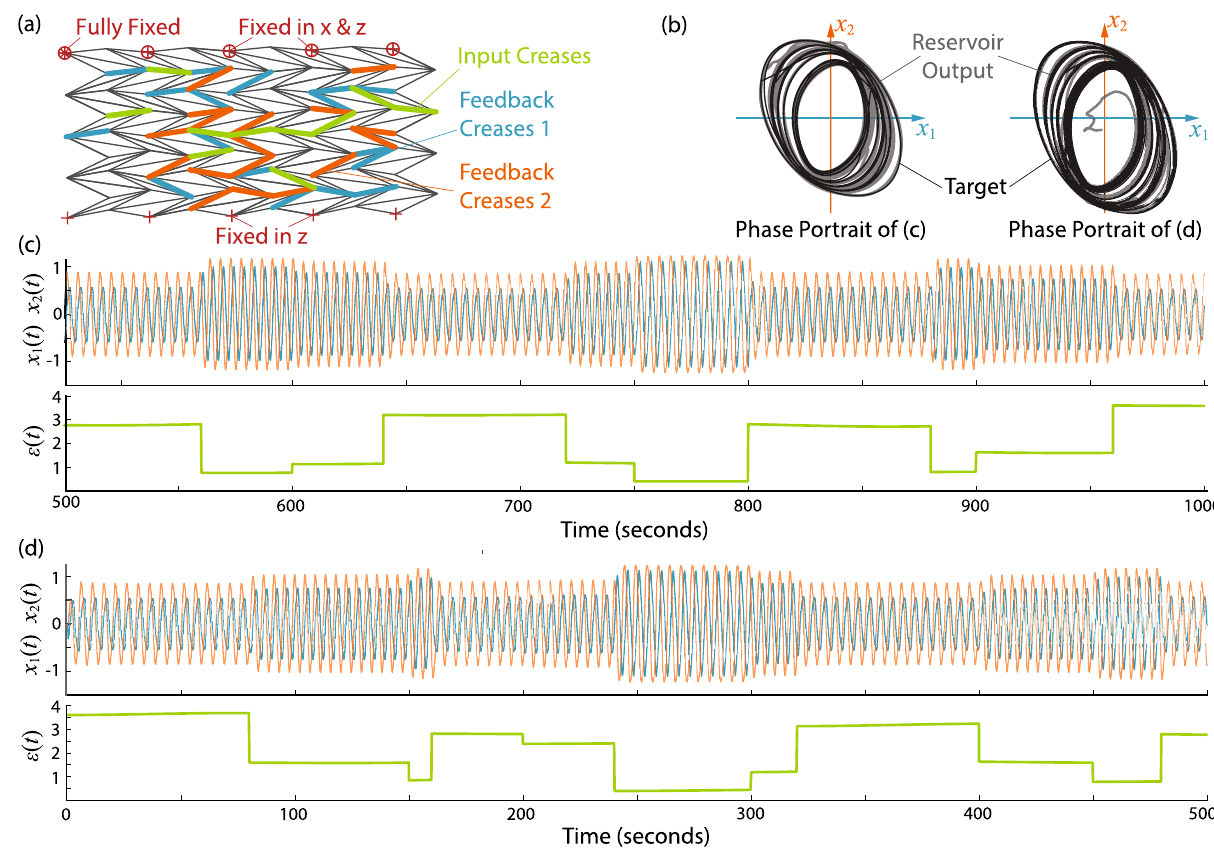
Figure 6. Results of modulation task under closed-loop using The Miura-ori reservoir. ( a ) This task’s origami reservoir includes two groups of feedback creases and input creases. ( b ) The phase-portraits, where the targeted trajectories are overlaid on top of the reservoir output. ( c ) Quadratic limit cycle trajectories under closed-loop and the corresponding input signal ǫ( t ) . The results are obtained after 500 seconds of training. ( d ) Closed-loop trajectory recovery from the initial resting Figure 5b–d show the results of Quadratic limit cycle, Van der Pol oscillator and Lissajous curve generation task, respectively. The origami reservoir can generate all three periodic trajectories just by changing the output readout weights. The MSE for Quadratic limit cycle, Van der Pol oscillator, and Lissajous curves, calculated using the data for first 10 seconds’ closed-loop run (M = 10000), are 3.28 × 10 − 7 , 2.03 × 10 − 5 , and 5.5 × 10 − 4 , respectively. As expected, MSE increases as the complexity of the curve increases.